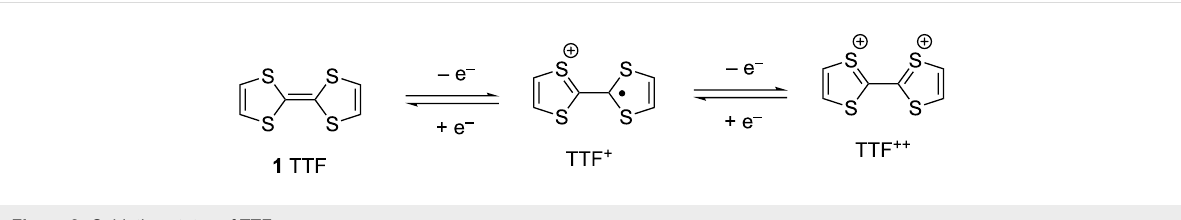
Figure 2: Oxidation states of TTF.